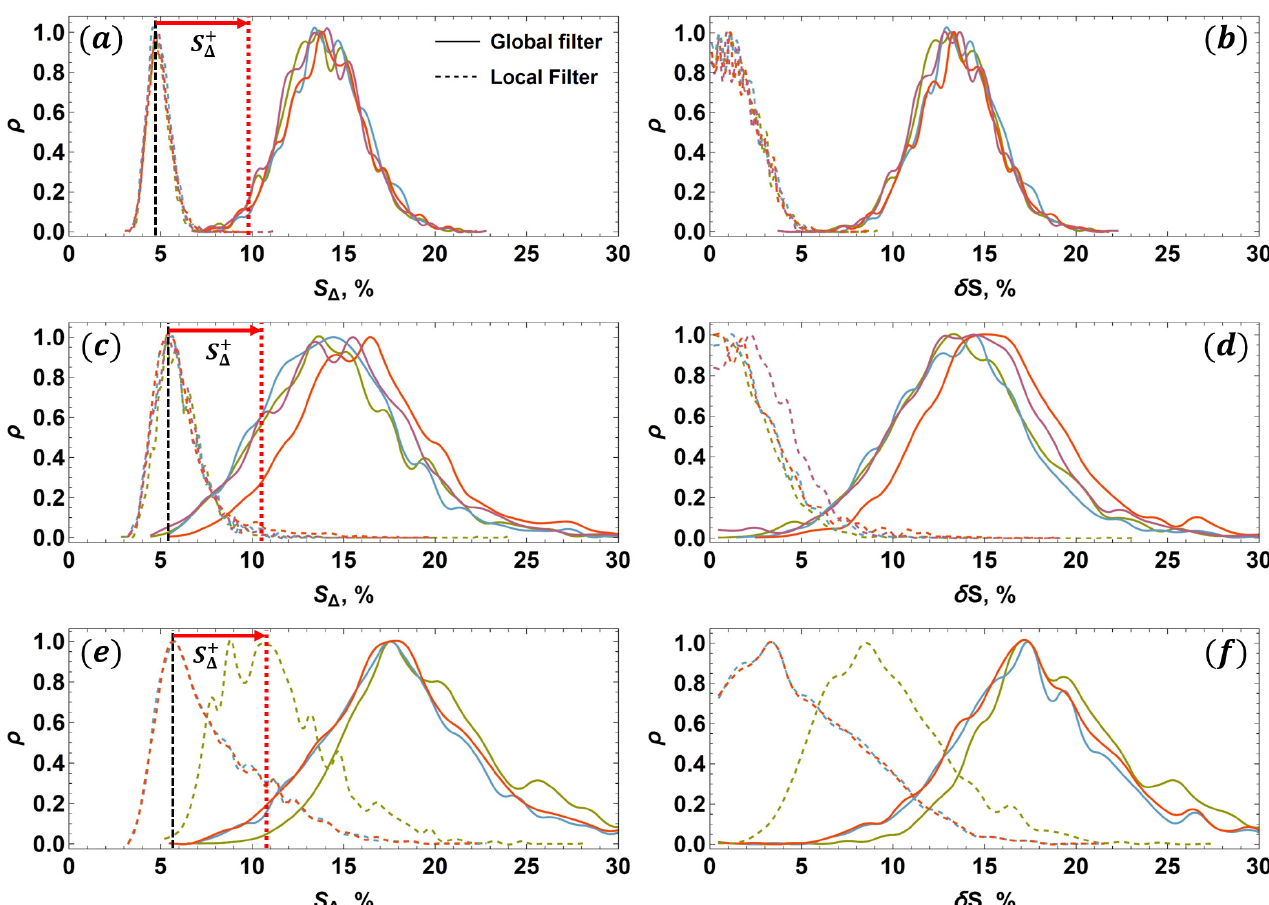
Figure 28. Smooth normalized S ∆ ( a , c , e ) and δ S ( b , d , f ) histograms for the cases with a moving body (pendulum): neutron flux transmission along the ( a , b ) smaller axis, ( c , d ) larger axis and ( e , f ) the latter with the addition of synthetic image artefacts. Note the legend in the upper-right corner of ( a ) indicating the results for the global and local filtering. Colors indicate different imaging instances. S + ∆ is the correction for the reference mask fitting bias (red